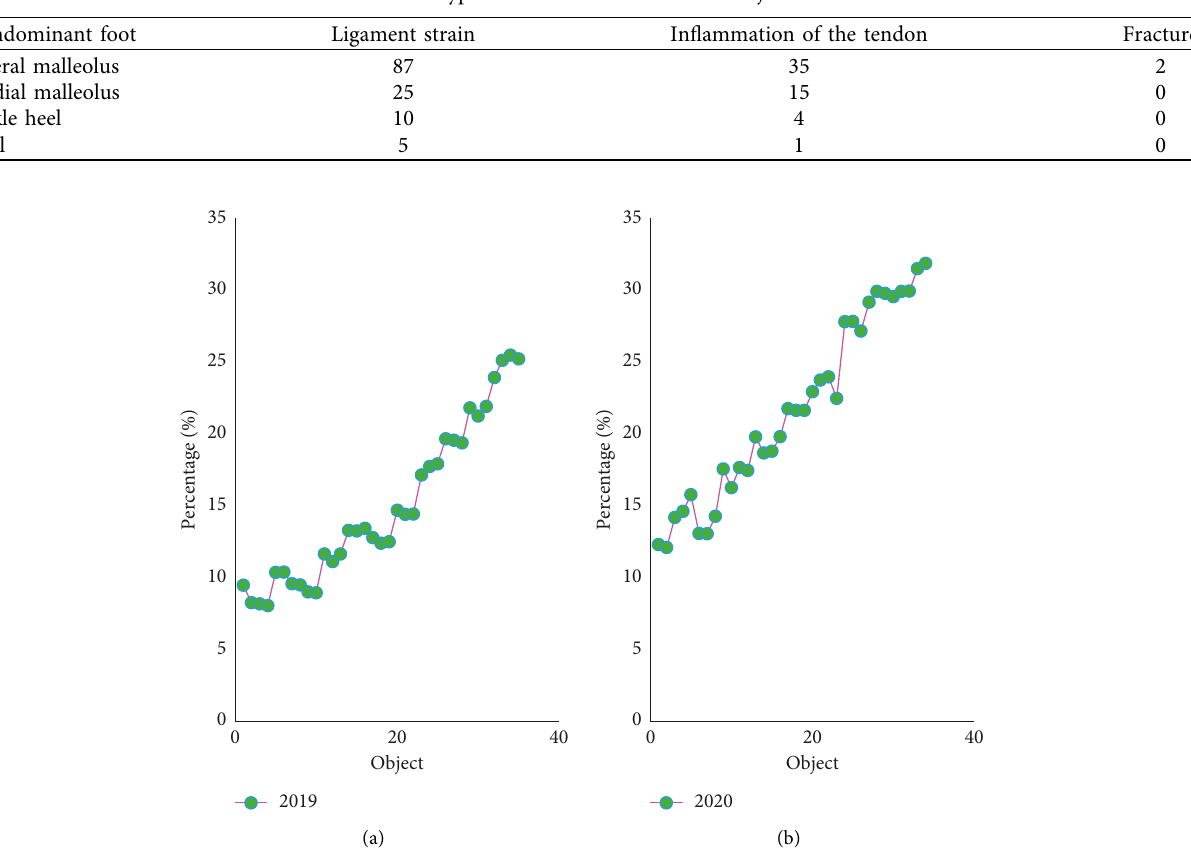
Table 2: Types of nondominant foot side injuries.